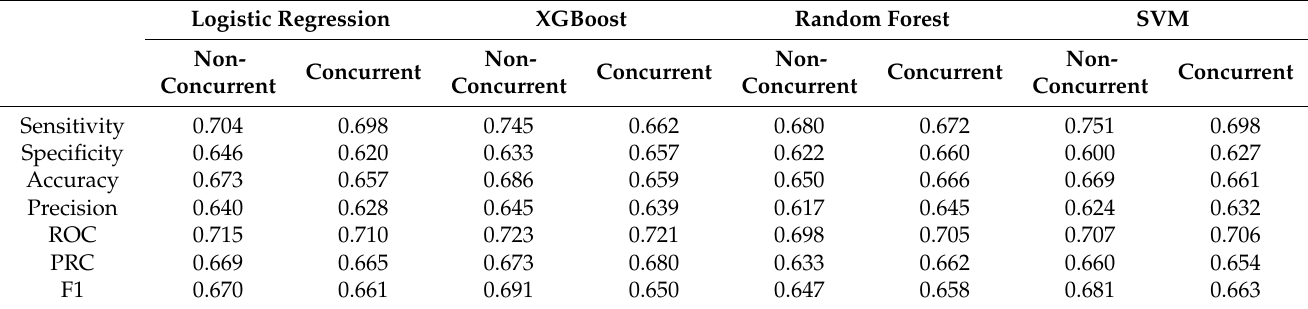
Table 4. Model predictions of osteopenia in the third stage (2012–2014) using concurrent and non-concurrent